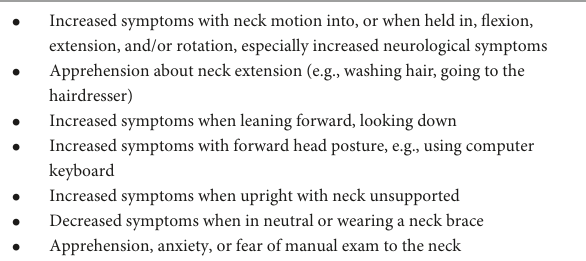
Screening for yellow flags Yellow flags (YF) are psychosocial symptoms or risk factors that may exacerbate presentation of any medical condition,